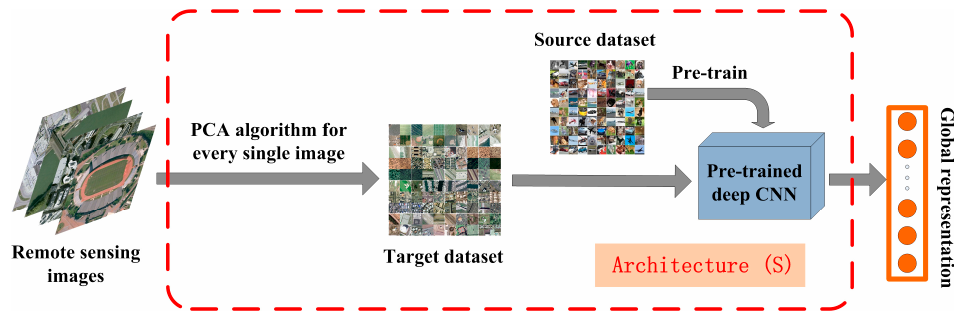
Figure 14. Illustration of the Architecture (S). Table 3. Classification accuracy (%) of Architecture (S), Architecture (I) and Off-the-shelf on UC Merced dataset.